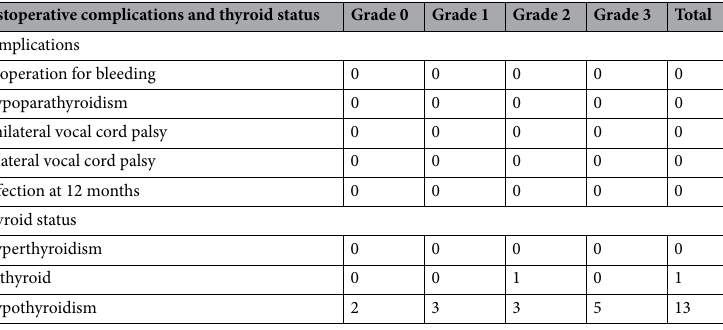
Table 3. Postoperative complications and thyroid status. Data are presented as number of